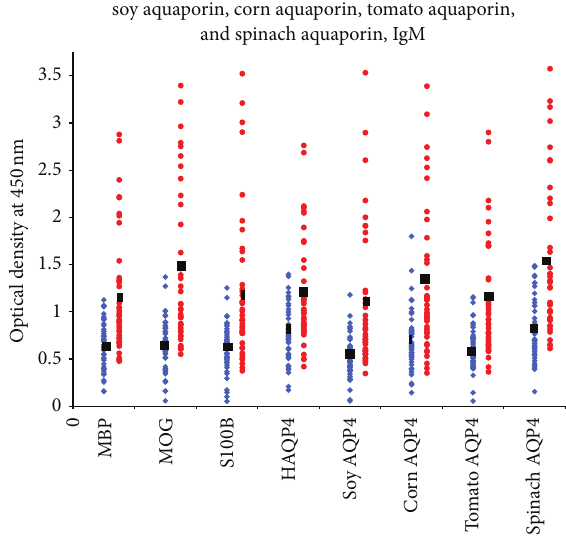
Figure 1: IgG antibody values of RRMS patients (blue diamond) versus controls (red circle): MBP, MOG, S100B, human AQP4, soy aquaporin, corn aquaporin, tomato aquaporin, and spinach aqua- porin. The levels of serum IgG antibodies against almost all tested antigens were significantly higher in patients than in controls.